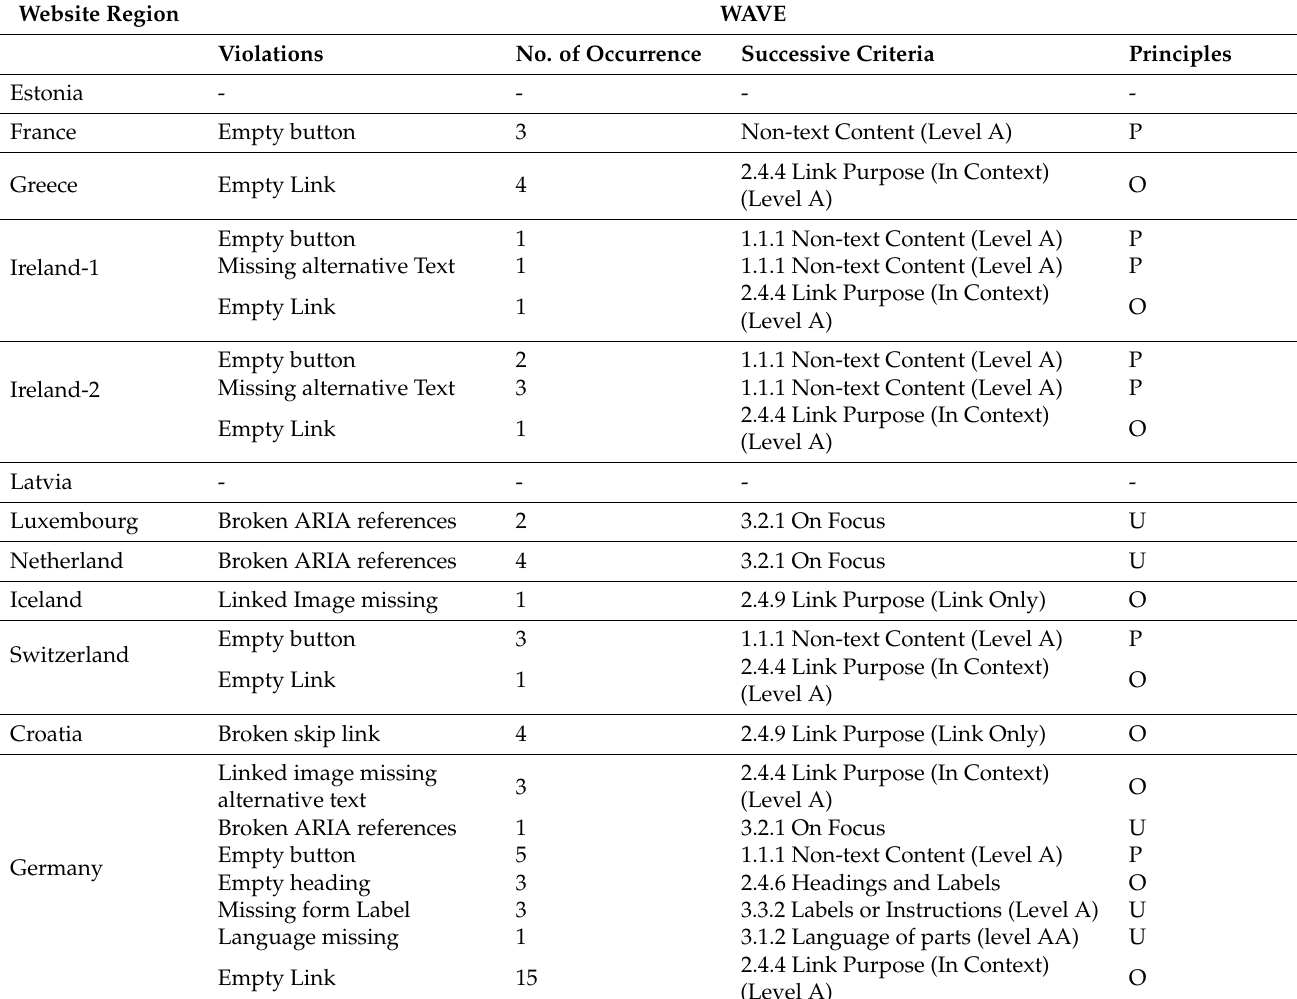
Table A4. Accessibility issues in the website of each country by